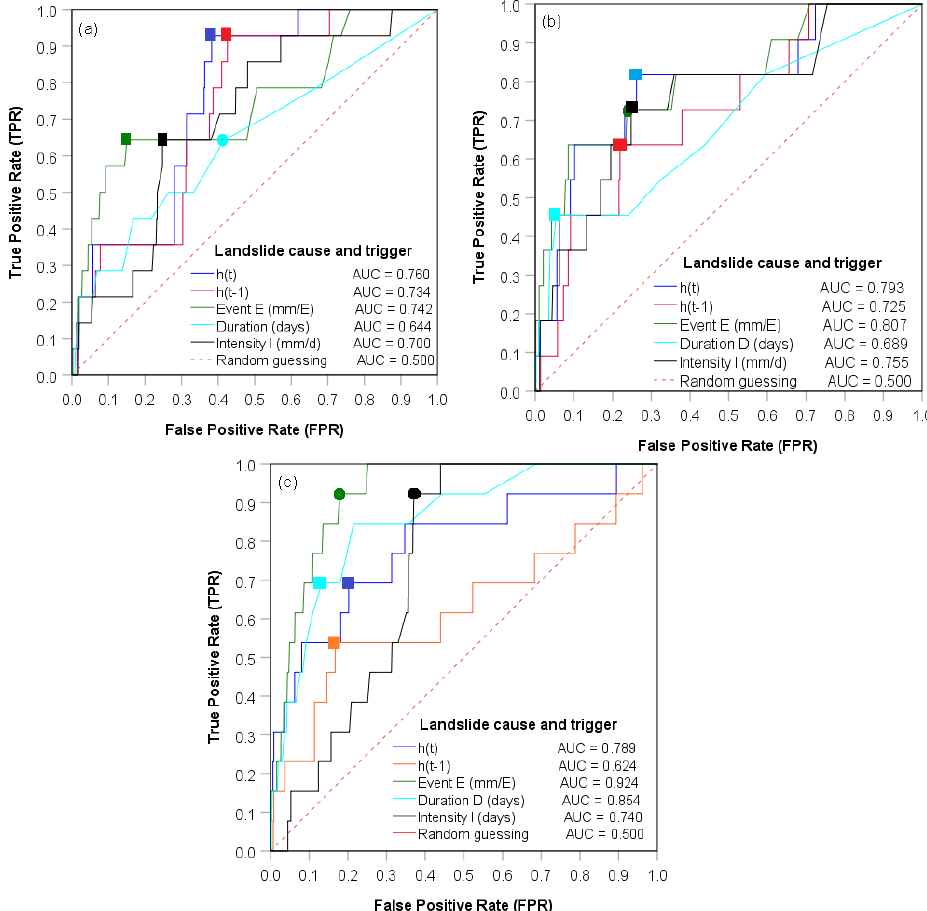
Figure 6. Receiver operating characteristic (ROC) curves and area under the curve (AUC) for each landslide predictor variable in the studied catchments: (a) Kivu, (b) upper Nyabarongo, and (c) Mukungwa. The optimum thresholds defined using the maximum true skill statistics (TSS) are presented with square-shaped markers, while circle-shaped markers are thresholds defined with the minimum radial distance (Rad); once TSS and Rad reveal different threshold values, the optimum (with maximum TPR and minimum FPR) is kept; once TSS and Rad reveal similar threshold values, only the square-shaped marker (TSS) is kept. The corresponding balance of true and false positive rates is also